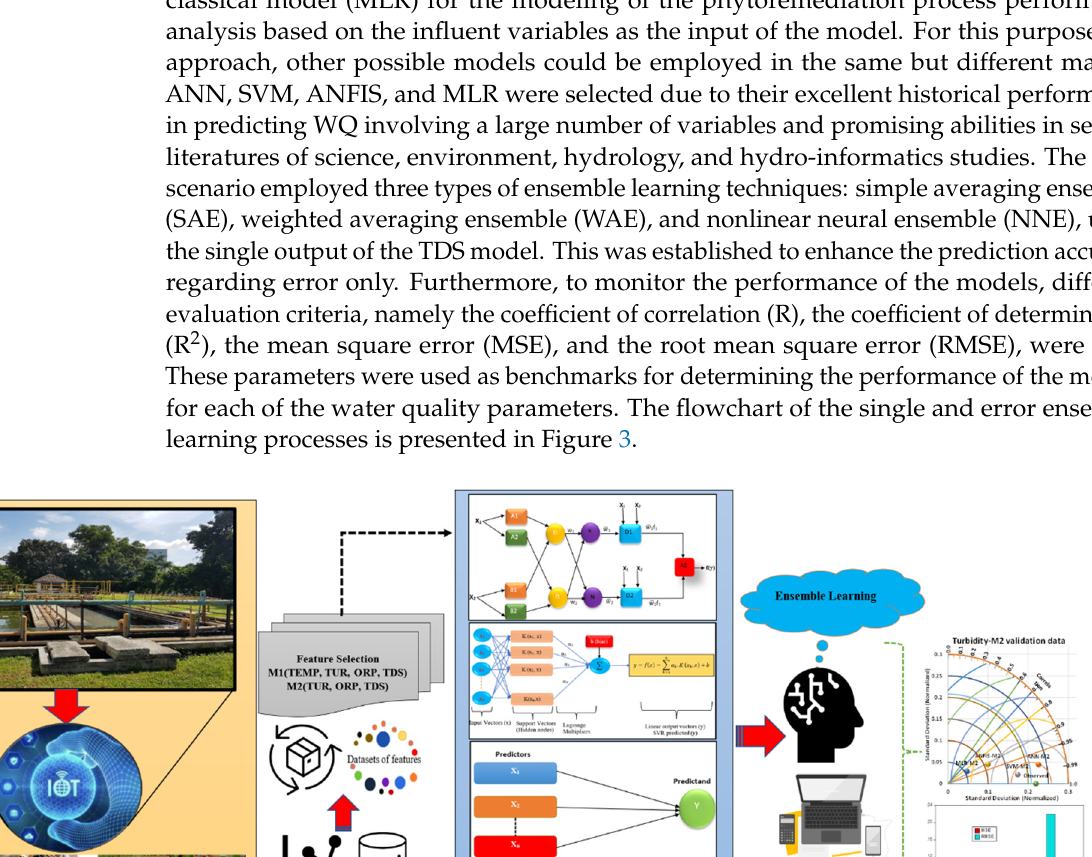
Table 1. Parameters used (influent (raw) and effluent (treated) samples).